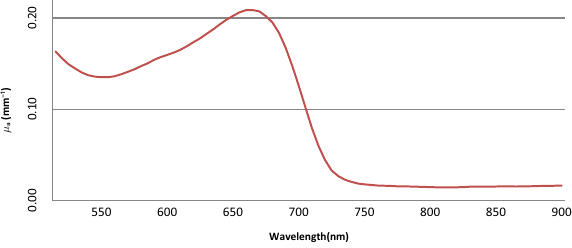
Fig. 7. Absorption coe±cient spectrum of Pierce TM 660 nm